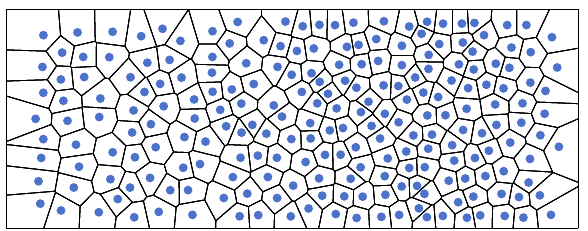
Figure 2. Voronoi diagram: For each agent, a Voronoi cell is shown which contains all points that are closer to this agent than to any other agent. The size of a Voronoi cell gives an indication of the agents free space and it is used to determine the density.